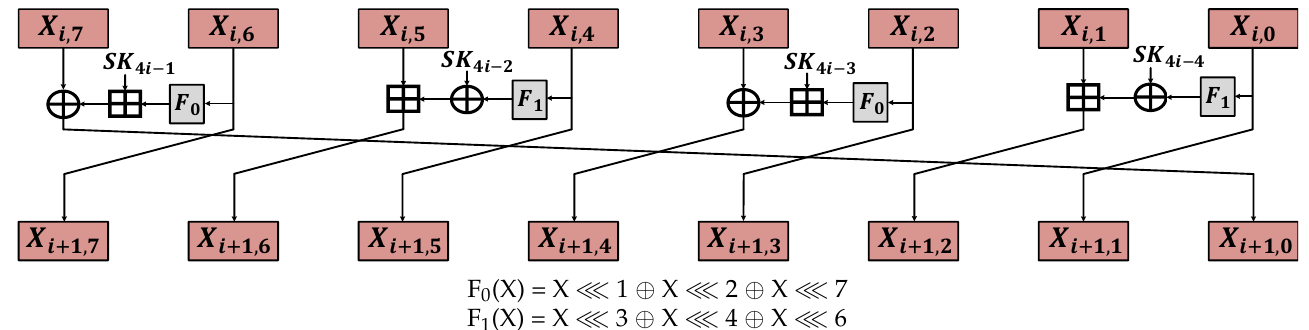
Figure 3. HIGHT round function [2] ( SK : subkey, F 0 , F 1 : functions, and ≪ : rotate